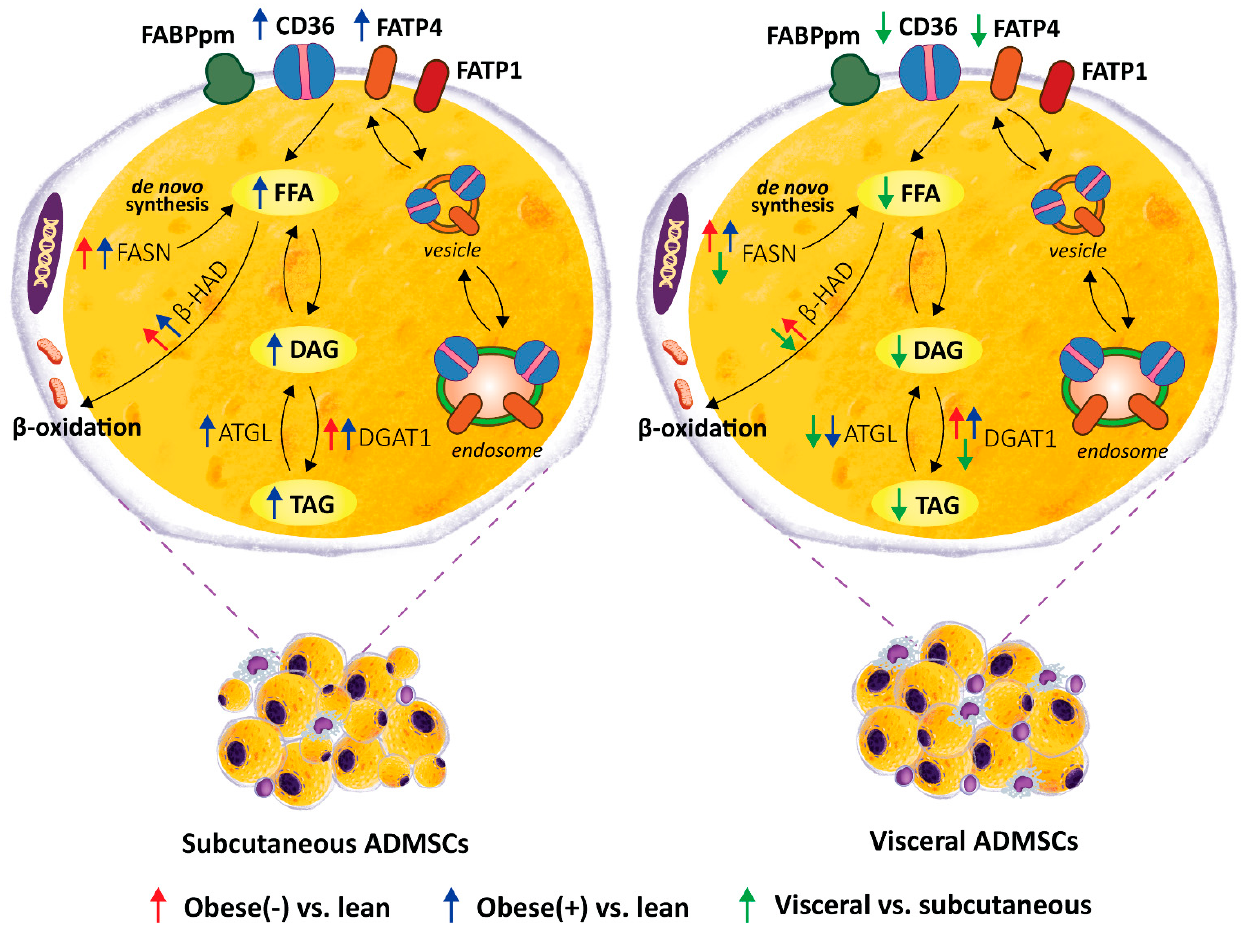
Figure 8. Graphical summary of the lipid profile of mature adipocytes derived from ADMSCs of lean and obese (with/without metabolic syndrome) postmenopausal women. A depot-specific pattern, with more pronounced changes present in the adipocytes obtained from subADMSCs was observed. Namely, morbid obesity triggered a relocation of fatty acid transporters i.e., CD36/SR-B2 and FATP4, from intracellular vesicles to the cell surface, which caused an increased LCFA influx ( 3 H-palmitate uptake) and promoted the accumulation of lipids in these cells. This was accompanied by a greater lipid turnover rate in the cells of subcutaneous provenance (greater protein expression of lipolytic enzymes, i.e., ATGL and β -HAD). On the other hand, the adipocytes of visADMSCs origin had lower lipid content and expression of lipid metabolizing enzymes, i.e., ATGL, β -HAD and FASN, when compared to their counterparts of subADMSCs ancestry.